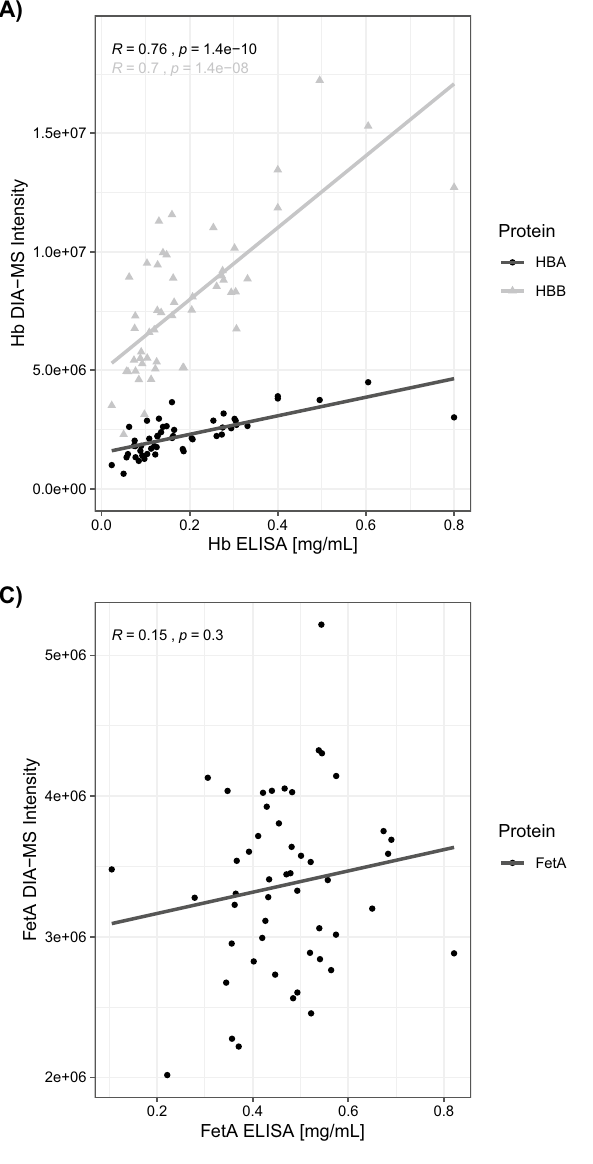
Figure 3. Scatterplots comparing protein concentrations measured via ELISA versus DIA-MS. Panel A1) hemoglobin (Hb) vs Hb alpha chain (HBA) and Hb beta chain (HBB). Panel B) fibrinogen (FIB) vs FIB chains alpha, beta, and gamma (FIBA, FIBB, FIBG) and Panel C) fetuin A (FetA). Correlations were assessed via Pearson for fibrinogen and fetuin A and via Spearman test for hemoglobin due to slight non-normal distribution of the HB ELISA data. Trendlines represent fits using linear regression models. Residual plots for model assessment provided as Supplementary Fig. 2. Figure generated using the ‘ggplot2 ′ (https ://githu b.com/ tidyv erse/ggplo t2) package within R/RStudio 17,18,37